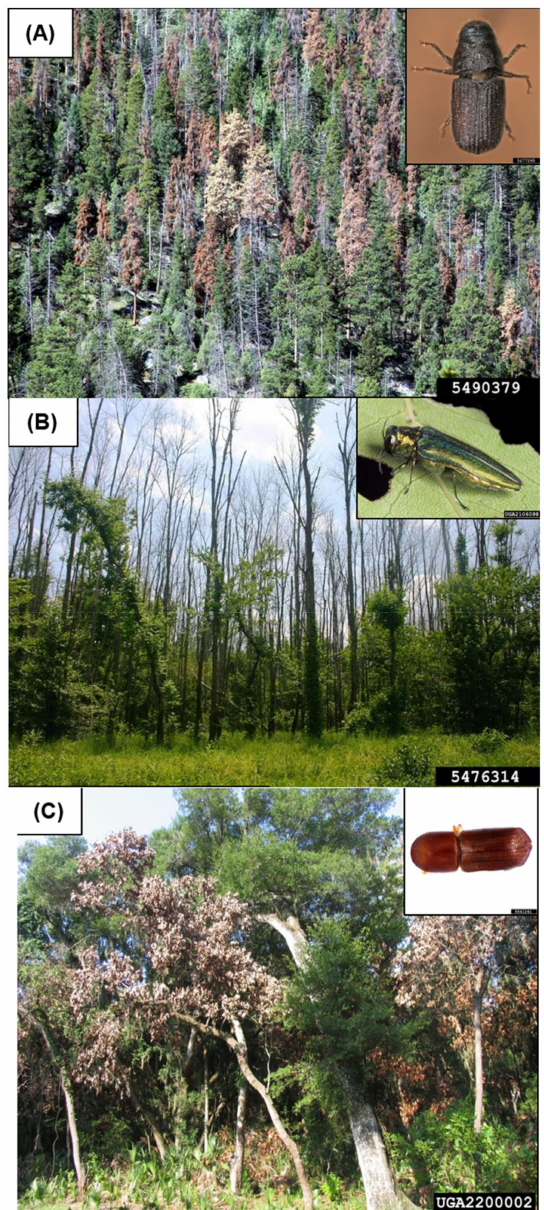
Figure 1. Examples of tree mortality caused by three native and non-native insects and diseases: ( A ) Mountain pine beetle (image credits: Whitney Cranshaw, Colorado State University, Bugwood.org and Javier E. Mercado, Bark Beetle Genera of the US, US Department of Agriculture (USDA), Animal and Plant Health Inspection Service (APHIS), Plant Protection and Quarantine (PPQ), Bugwood.org). ( B ) Emerald ash borer (image credits: Christopher Asaro, Virginia Department of Forestry, Bugwood.org and David Cappaert, Bugwood.org). ( C ) Redbay ambrosia beetle (image credits: Joseph Benzel, Screening Aids, USDA APHIS PPQ, Bugwood.org and Albert Mayfield, USDA Forest Service,